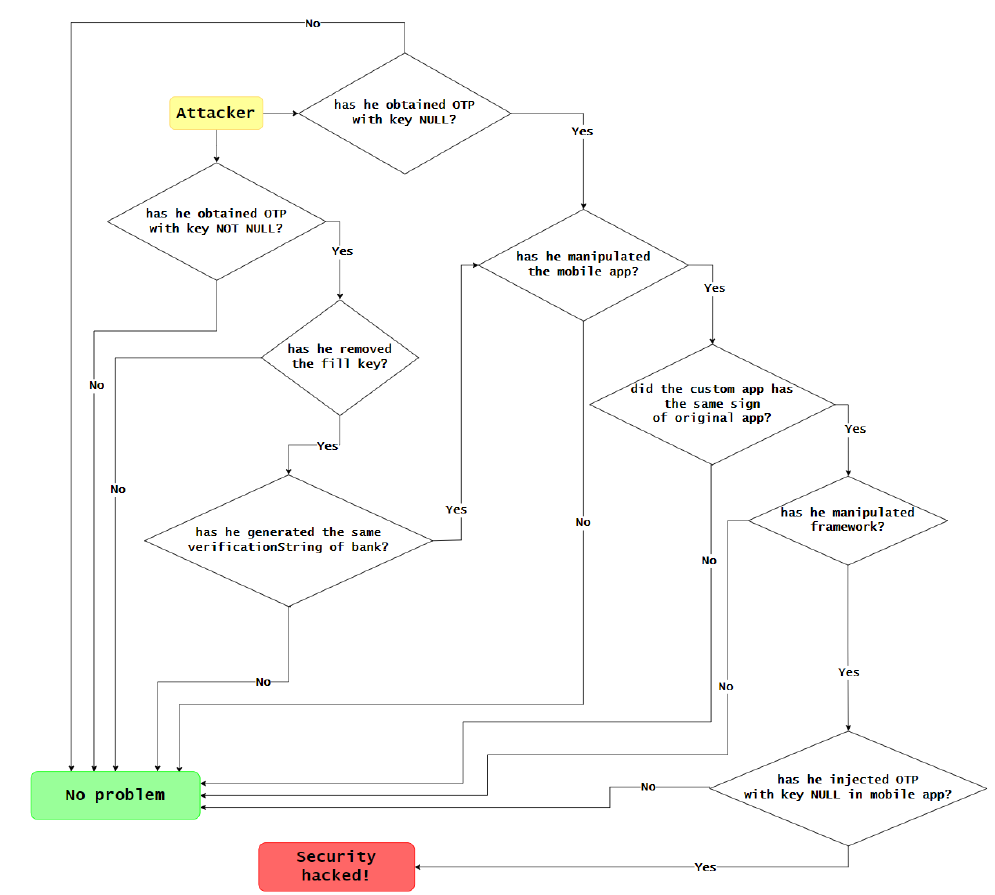
Figure 15. Steps an attacker must take to breach the